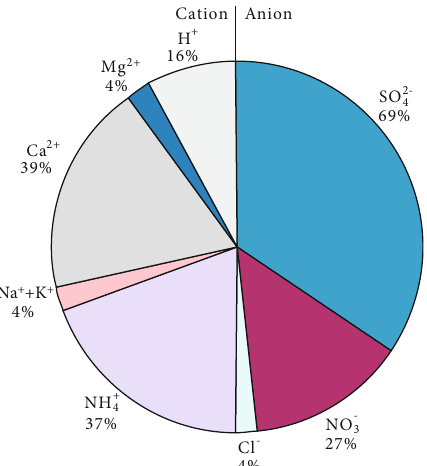
Figure 2: Precipitation ion compositions (% in meq/L). The ion compositions are the weighted average values from Jinyunshan, Beibei District, Chongqing, from 2013 to 2017. SO 42- , NO 3- , Ca 2+ , NH 4+ , and H + are the main ions in precipitation ( > 15%). The data are from